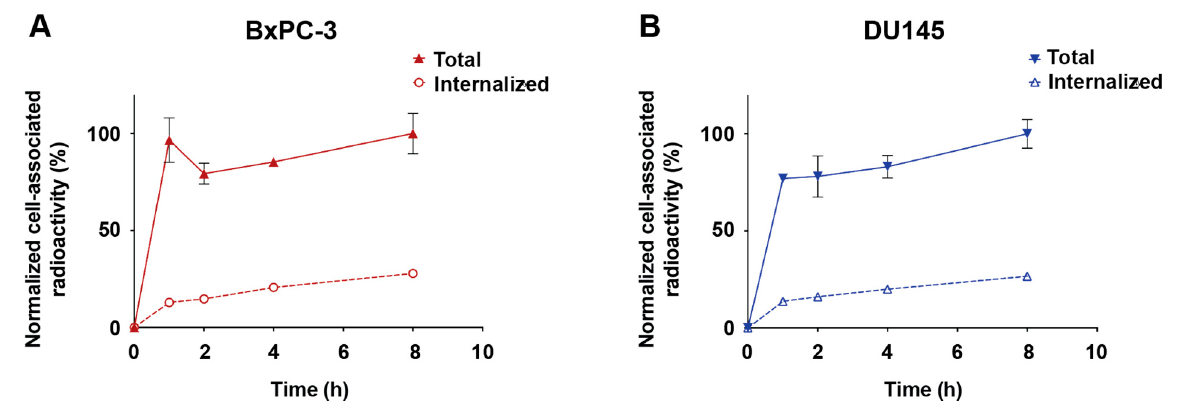
Figure 5. Cellular association and internalization of [ 99m Tc]Tc-Z HER3 -ABD-mcDM1 in BxPC-3 ( A ) and DU145 ( B ) cells. The cells, BxPC-3 and DU145, were subjected to continuous incubation with 0.1 nM [ 99m Tc]Tc-Z HER3 -mcDM1 at 37 °C. The percent of total cell-associated radioactivity and internalized radioactivity was measured and is plotted as a function of time. All values were normalized to the highest value observed (which was set to 100%). The data points represent the average values measured for three samples with error bars corresponding to 1 standard deviation. In some cases, the error bars are smaller than the symbols, and are therefore not visible.